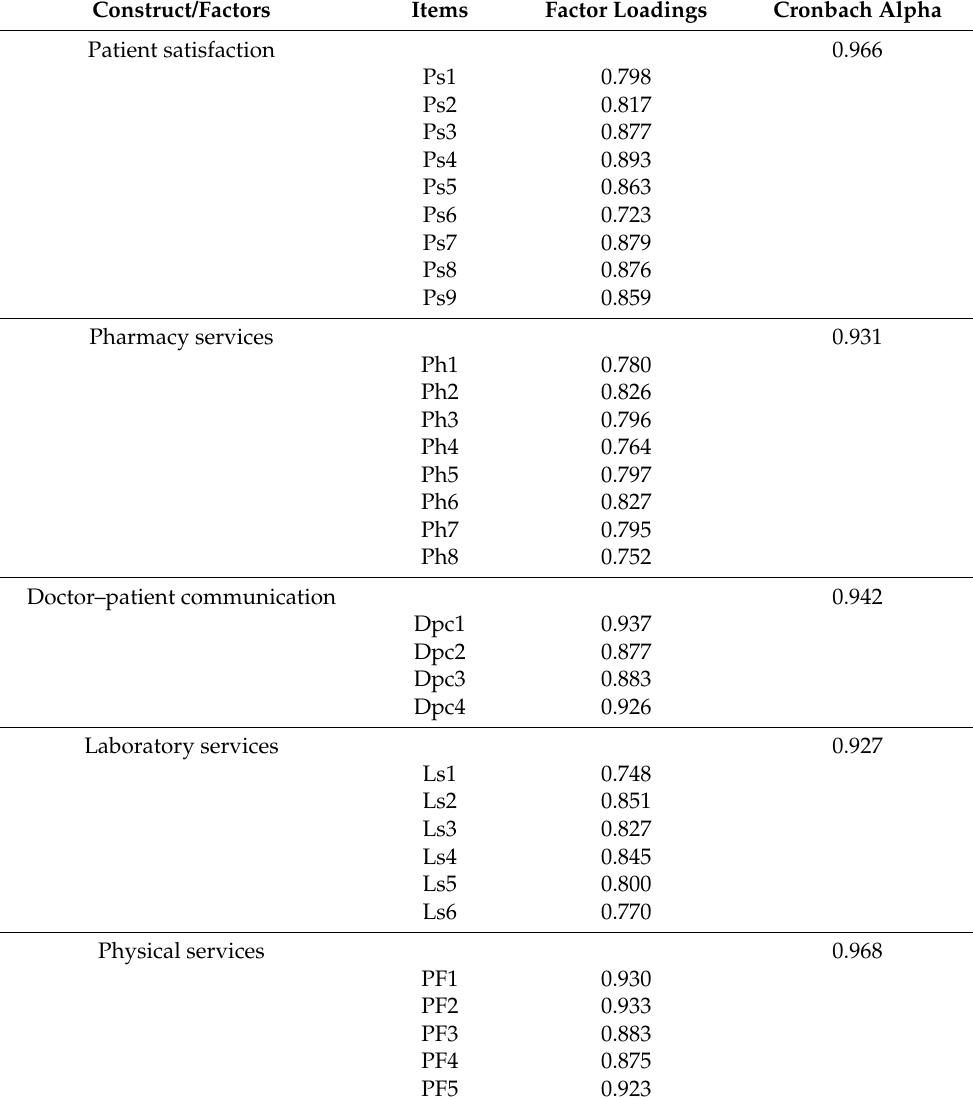
Table 7. Results of the confirmatory factor